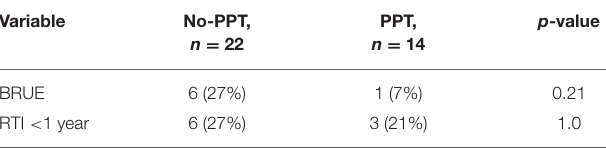
TABLE 6 | Respiratory outcome in group 2 (2017–2019).